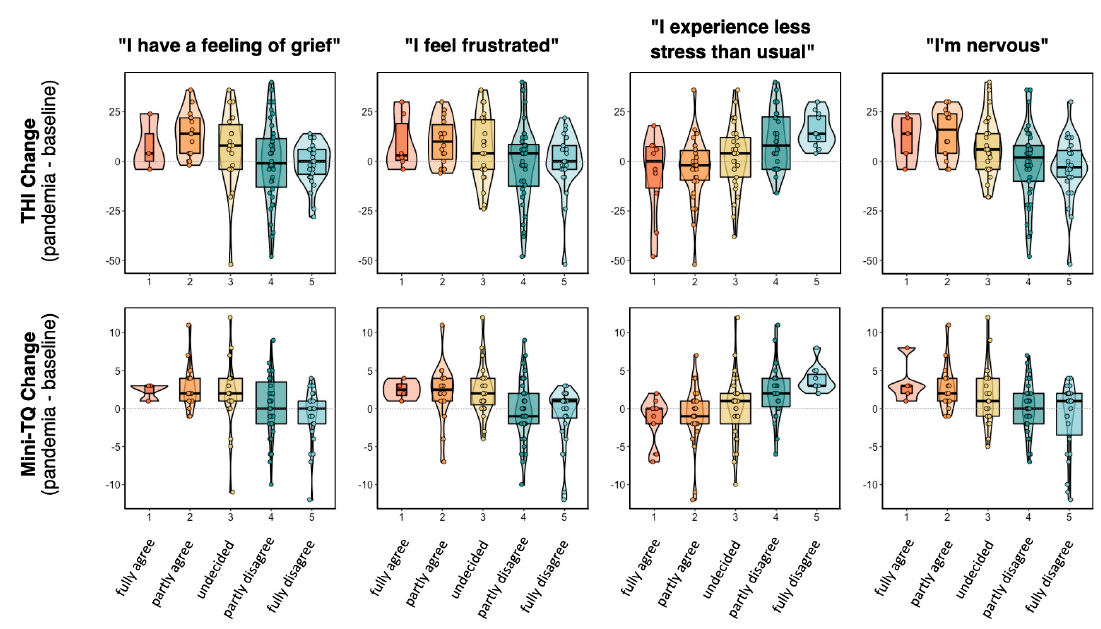
Figure 2. Relationship between pandemic-related burden and change of tinnitus distress. Change of tinnitus distress was calculated by subtracting time point 2 (pandemic situation) from time point 1 (baseline).